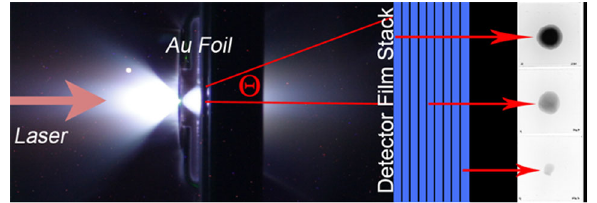
FIG. 1. Dosimetric film stack illustrating the recording of laser accelerated protons and the decrease in divergence angles (cid:1) for more energetic